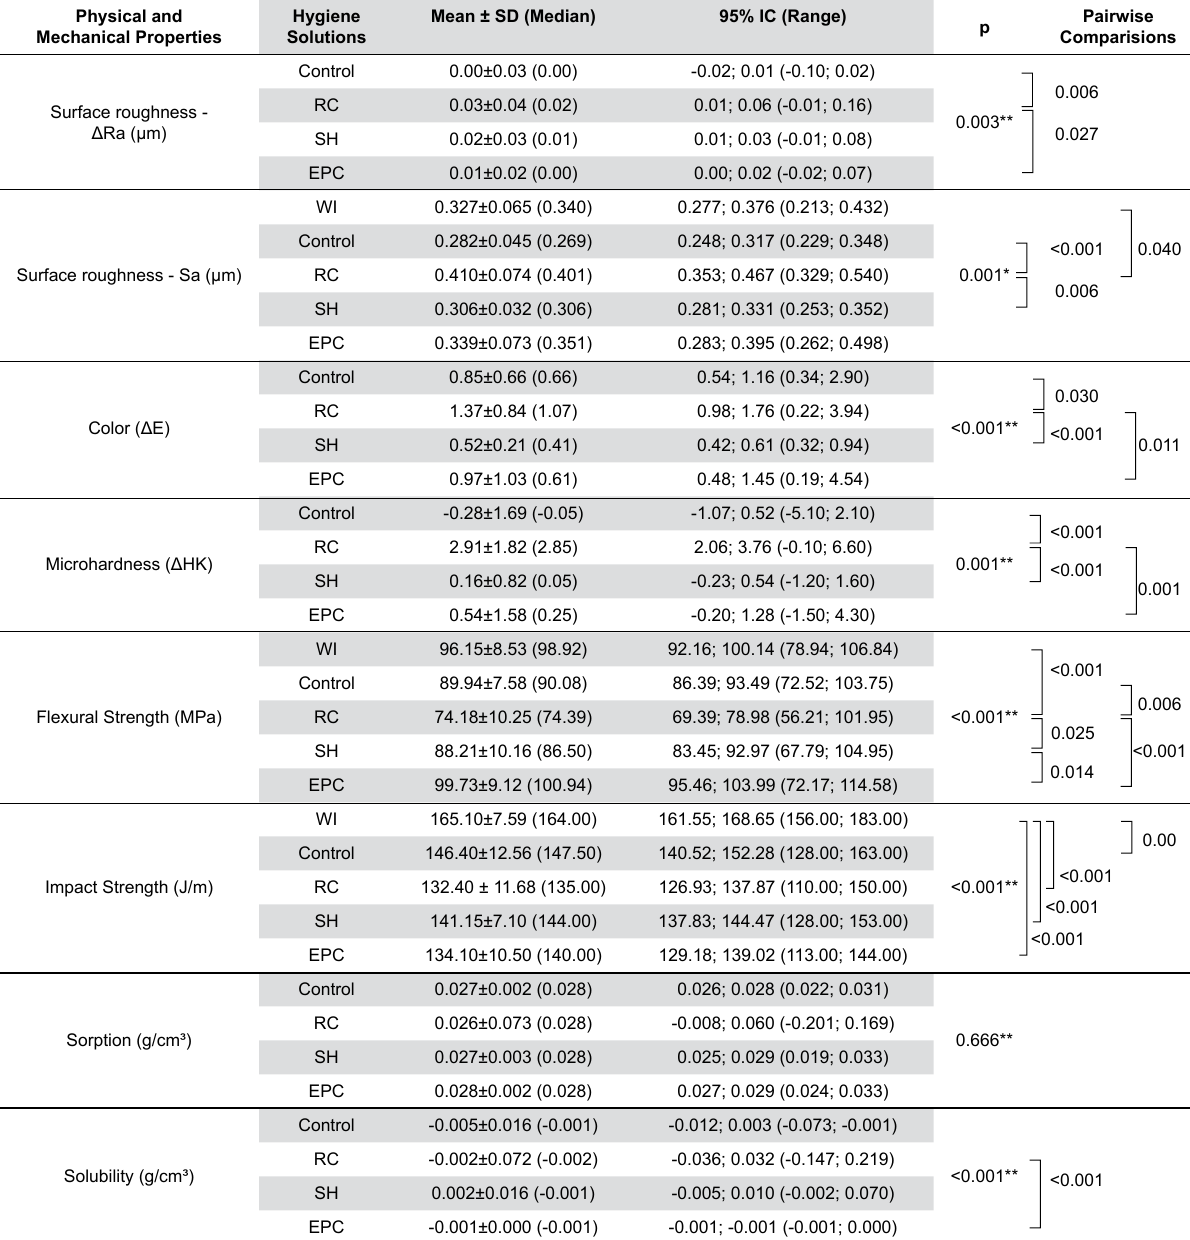
Table 2- Effects of different hygiene solutions on physical and mechanical properties of denture base